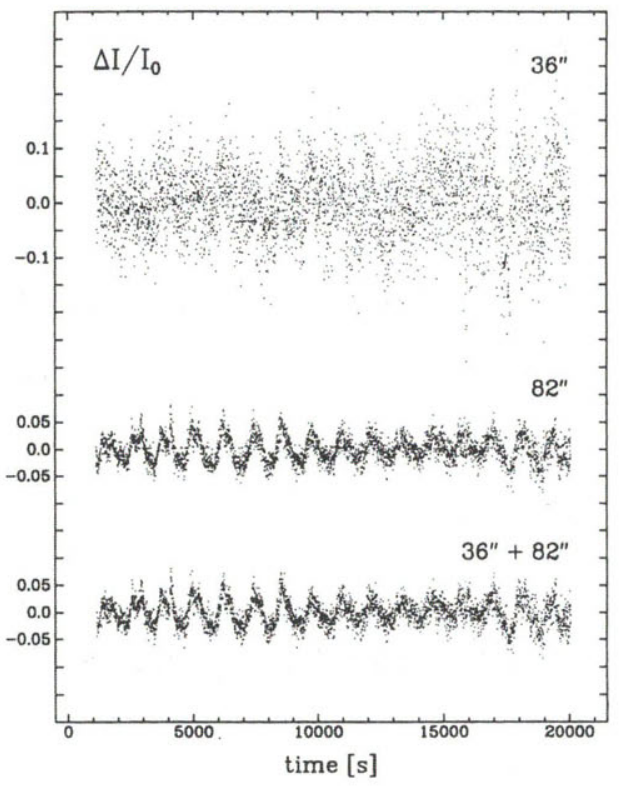
Fig. 1. Light curve of GD 154. Top: 36" telescope; middle-. 82" tele- scope; bottom: combined